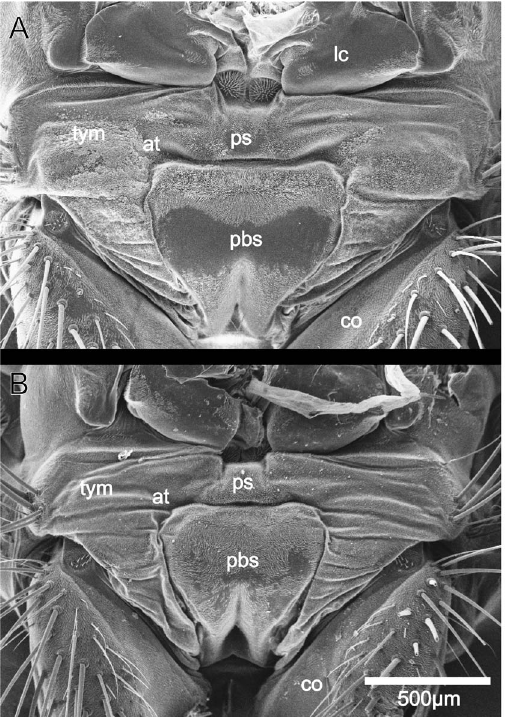
Figure 1. Scanning electon micrographs of the ear of a female (A) and a male (B) Emblemasomaauditrix . at: attachment site of the sensory cells, co: coxa of the foreleg, lc: lateral cervicale, pbs: probasisternite, ps: prosternite, tym: tympanal membrane. Dorsal is to the top.